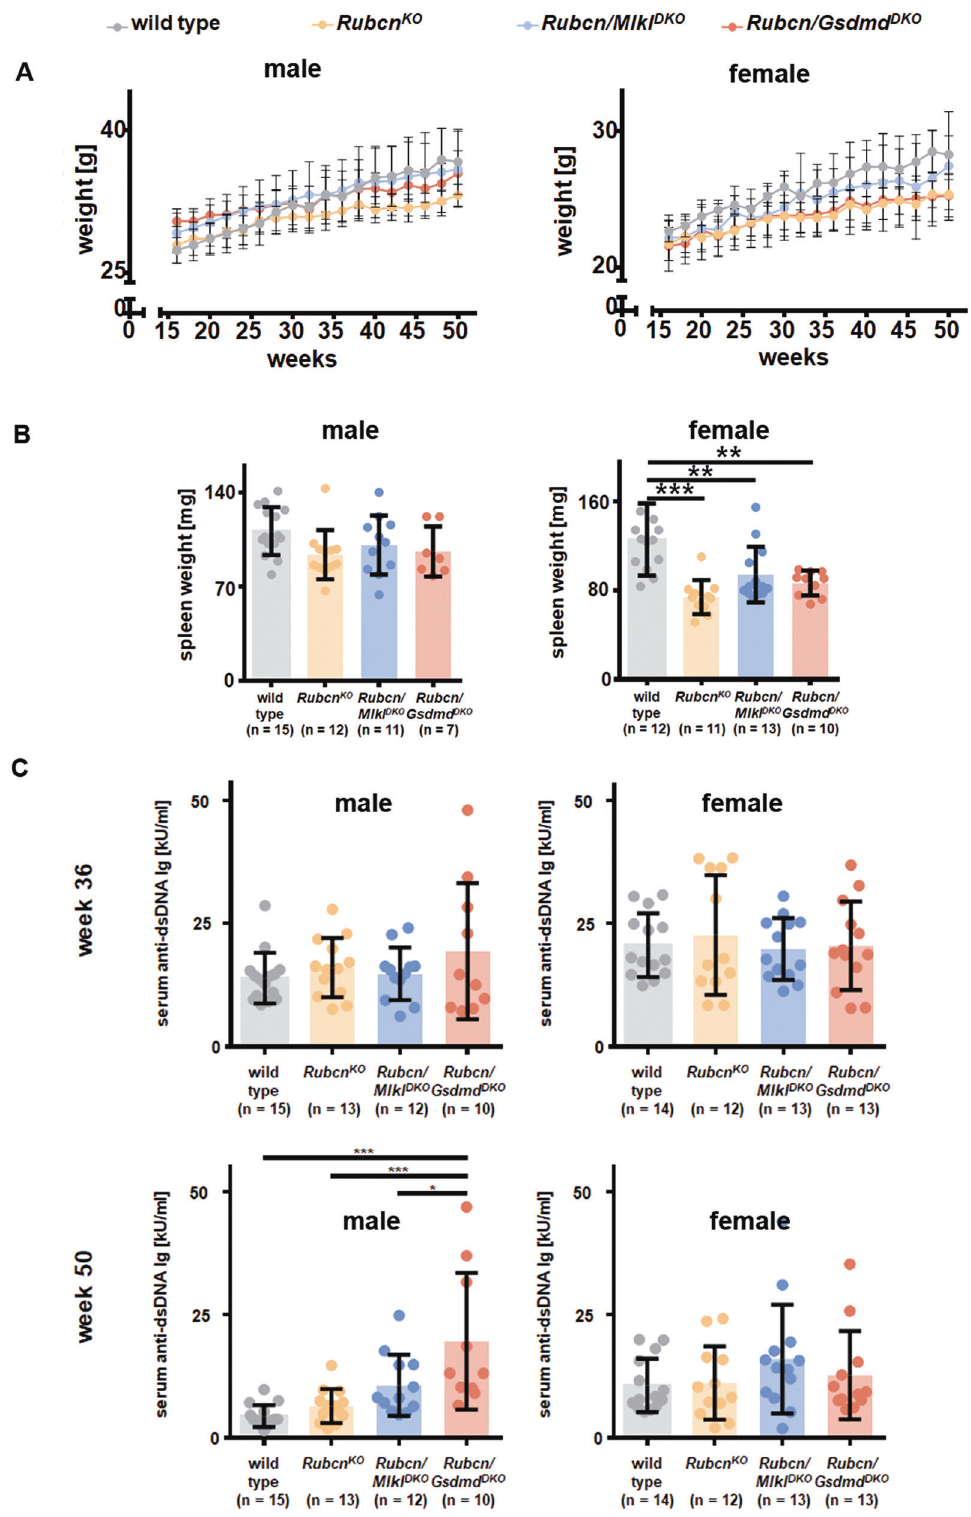
Fig. 4 RUBCN-de fi cient female mice display splenic atrophy but no signs of autoimmunity at 50 weeks of age. A Male and female RUBCN- de fi cient mice fail to gain weight over their fi rst 50 weeks of life compared to wild-type littermates (also see Fig. S6 for details). B In contrast to male mice, female mice show splenic atrophy at an age of 50 weeks as estimated by splenic weight. C Male and female wild-type mice and RUBCN-de fi cient littermates produce indistinguishable levels of autoantibodies against double-stranded DNA at 36 weeks and 50 weeks of age. Statistical analysis was performed one-way ANOVA analysis (* p < 0.05, ** p < 0.01, *** p < 0.001).